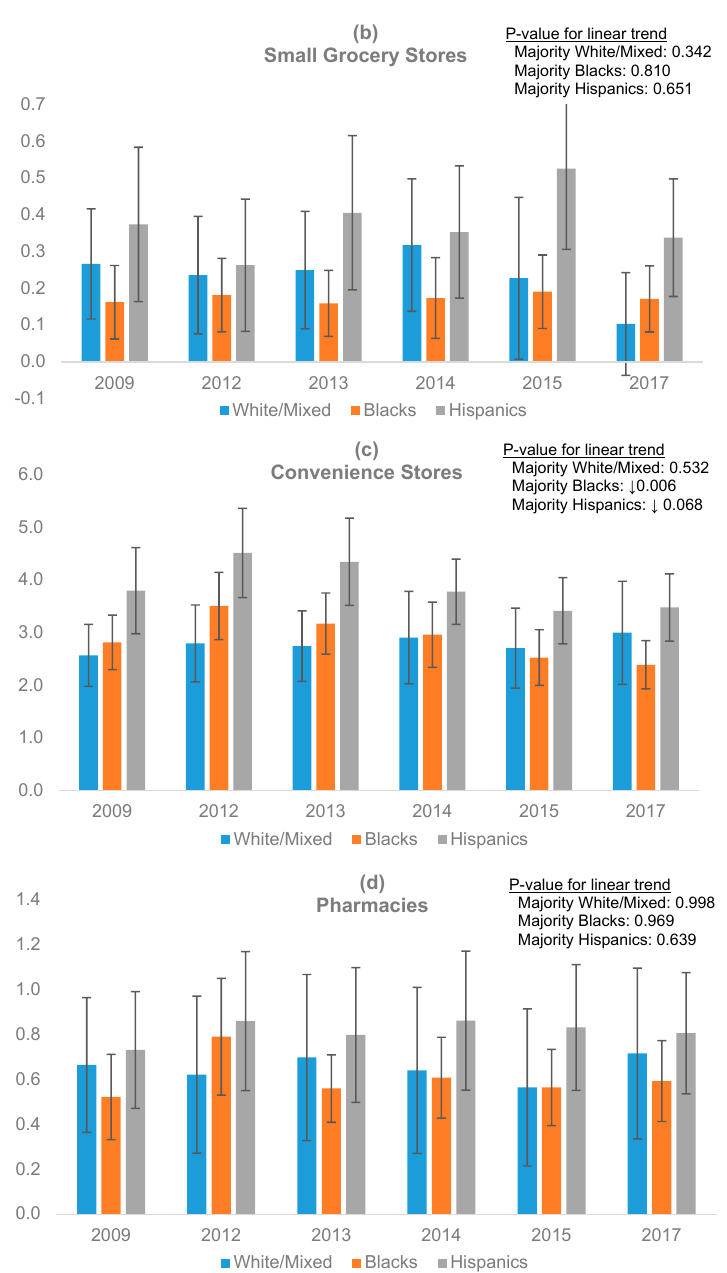
Figure 2. Expected number of ( a ) supermarkets; ( b ) small grocery stores; ( c ) convenience stores; ( d )